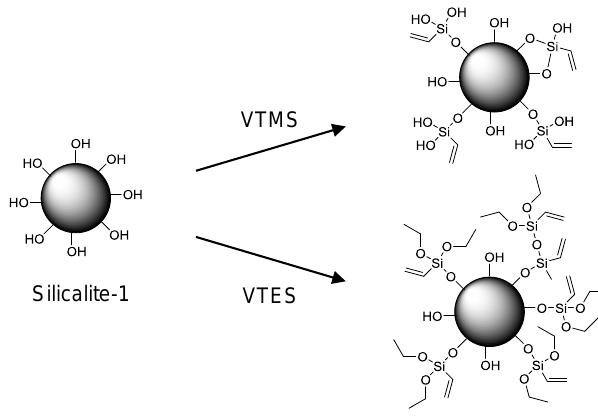
Figure 17. Modification of silicalite-1 with VTES [136] and VTMS [137] showing the incorporation of vinyl groups to the surface.